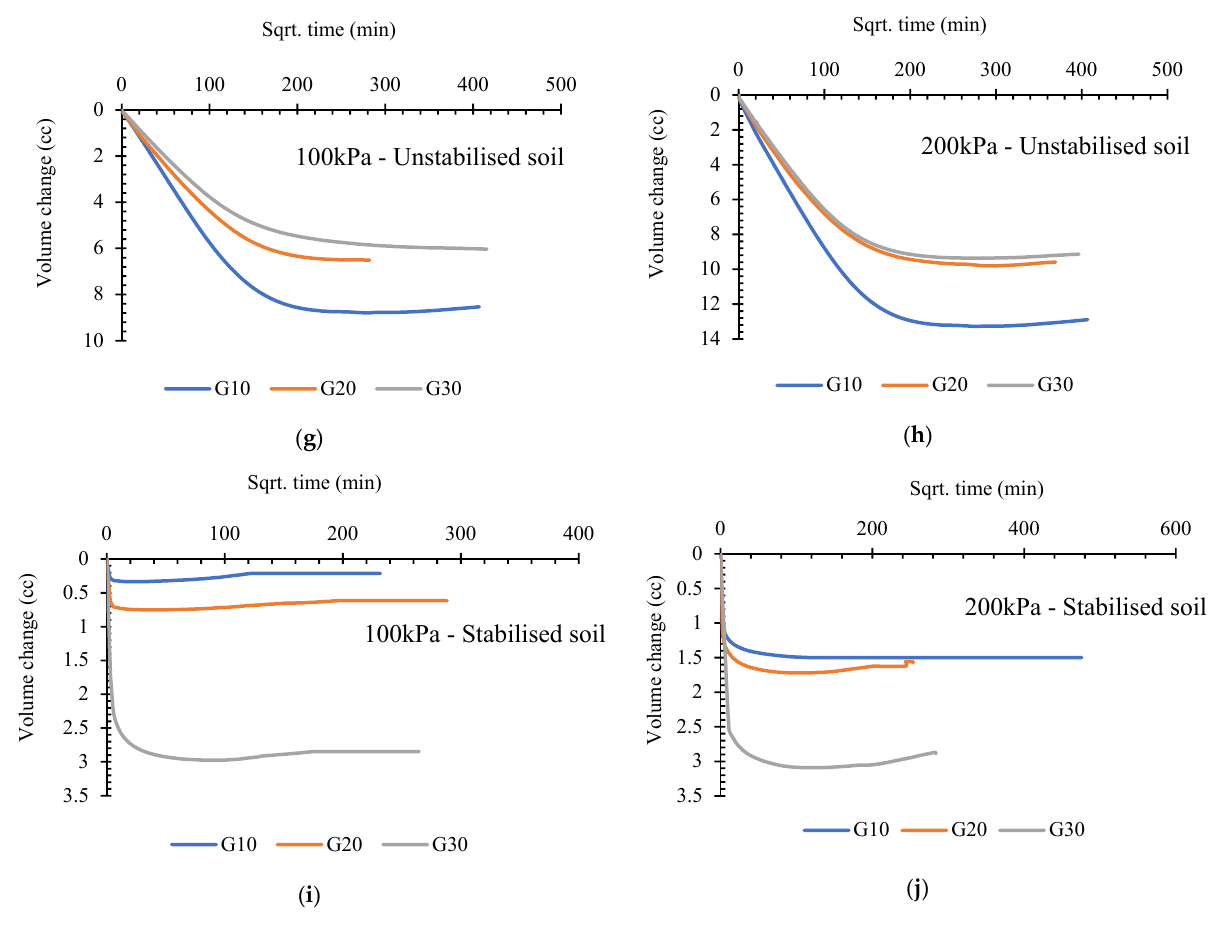
Figure 3. Volumetric and pore pressure responses: ( a ) 10% gypsum content and constant effective pressure of 100 kPa; ( b ) 10% gypsum content and constant effective pressure of 200 kPa; ( c ) 20% gypsum content and constant effective pressure of 100 kPa; ( d ) 20% gypsum content and constant effective pressure of 200 kPa; ( e ) 30% gypsum content and constant effective pressure of 100 kPa; ( f ) 30% gypsum content and constant effective pressure of 200 kPa; ( g ) consolidation of unstabilised soil under constant effective pressure of 100 kPa; ( h ) consolidation of unstabilised soil under constant effective pressure of 200 kPa; ( i ) consolidation of stabilised soil under constant effective pressure of 100 kPa; ( j ) consolidation of stabilised soil under constant effective pressure of 200